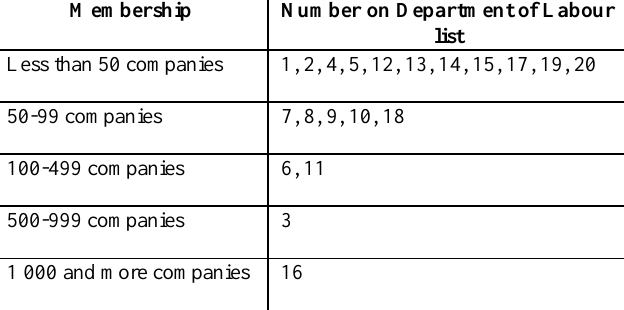
Table 1: Classification method used for employers' organisations on the Department of Labour